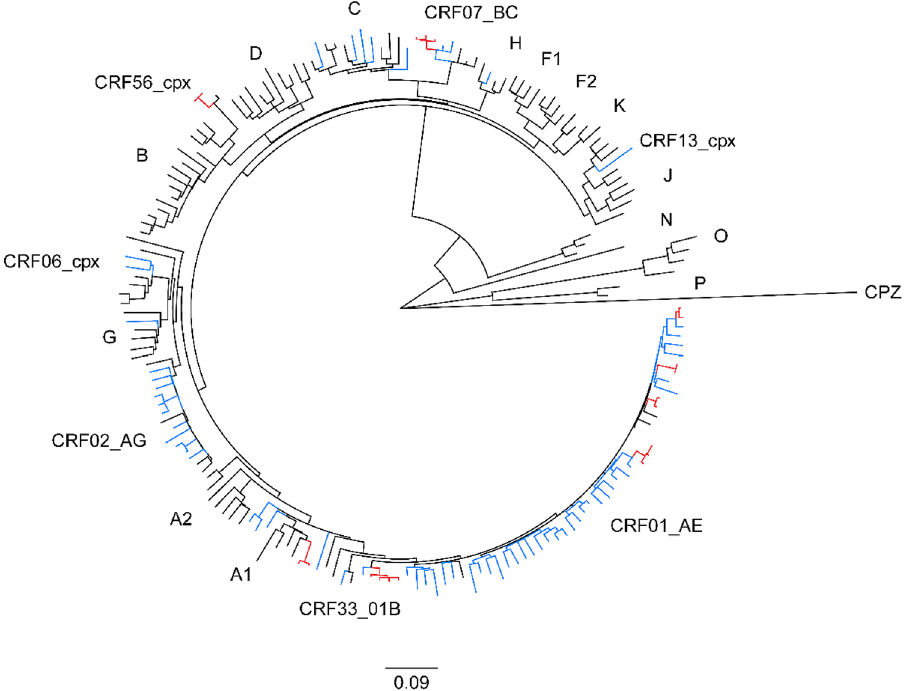
Figure 5. Maximum-likelihood phylogenetic tree of HIV-1 non-B subtype pol sequences from 83 antiretroviral therapy-naïve HIV-infected patients in Busan, Korea and 104 references from the Los Alamos National Laboratory (LANL) HIV database (http:// www. hiv. lanl. gov). The maximum likelihood tree was constructed using MEGA version 10.1.8 (https:// www. megas oftwa re. net) under the GTR + G + I model with 1000 bootstrap replicates. The black branch color represents the reference sequences, and the blue branch color indicates the study sequences, with the 8 transmission clusters highlighted in